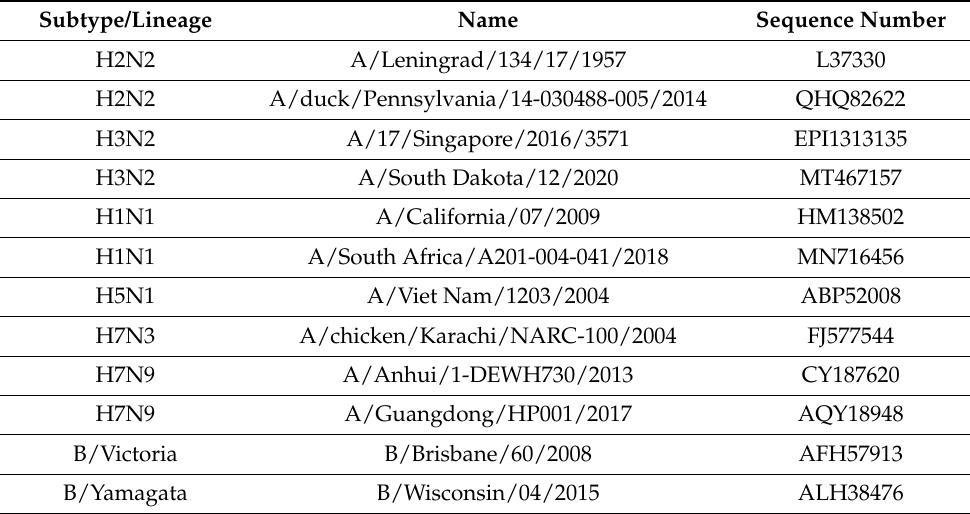
Table 1. The influenza viruses used for the molecular analysis of the NA gene.